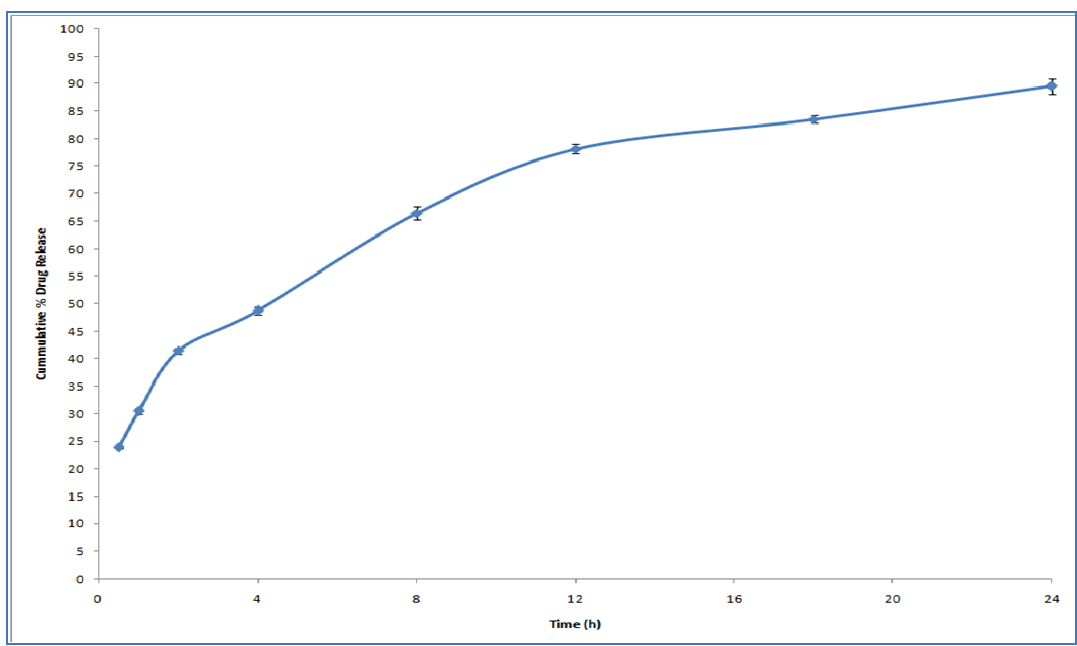
Figure 4. In vitro release profile of CS NPs loaded with MDZ (F32 D1).